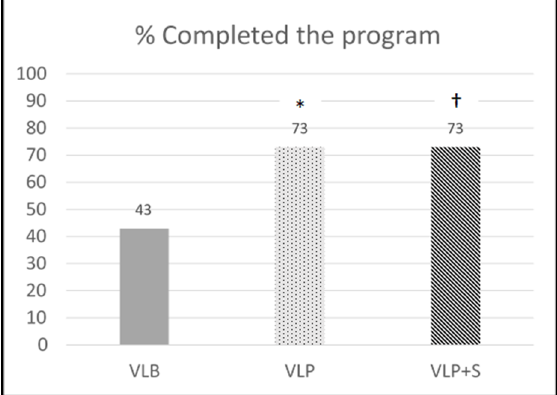
Figure 1. Retention rate by intervention group. VLB = Vibrant Lives Basic; VLP = Vibrant Lives Plus; VLP + S = Vibrant Lives Plus with Support; * significant differences between VLB and VLP groups; † significant differences between VLB and VLP + S groups.